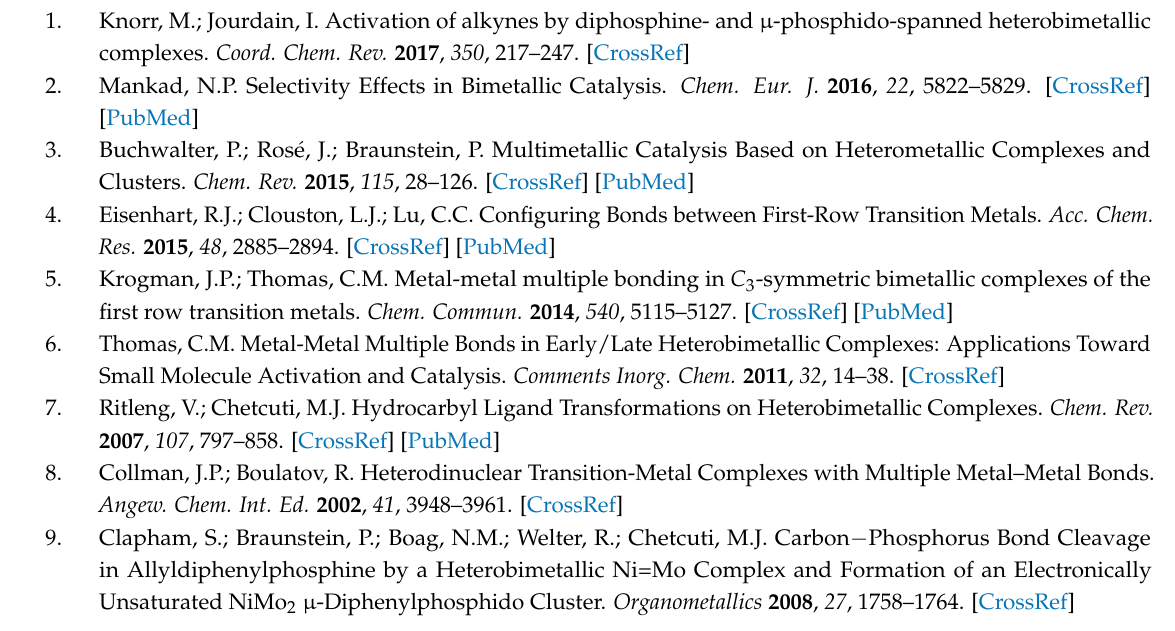
A PDF file containing: Figure S1: Structure of compound H . Table S1: Geometry of H . Table S2: Selected molecular orbitals for H . Figure S2: IR spectra for compounds 3a and 4 . Figure S3: IR spectrum of compound 2 . Figure S4: 1H NMR spectrum of compound 2 . An XYZ file containing the Cartesian coordinates of all computed species, a CIF file containing full crystallographic data for compounds 2 and 3a , and the corresponding checkcif file. Author Contributions: D.G.-V. and M.A.R. designed the experiments and wrote the paper; E.H. performed the experimental work; M.A.A. carried out the crystal structure determinations; D.G.-V. performed the theoretical